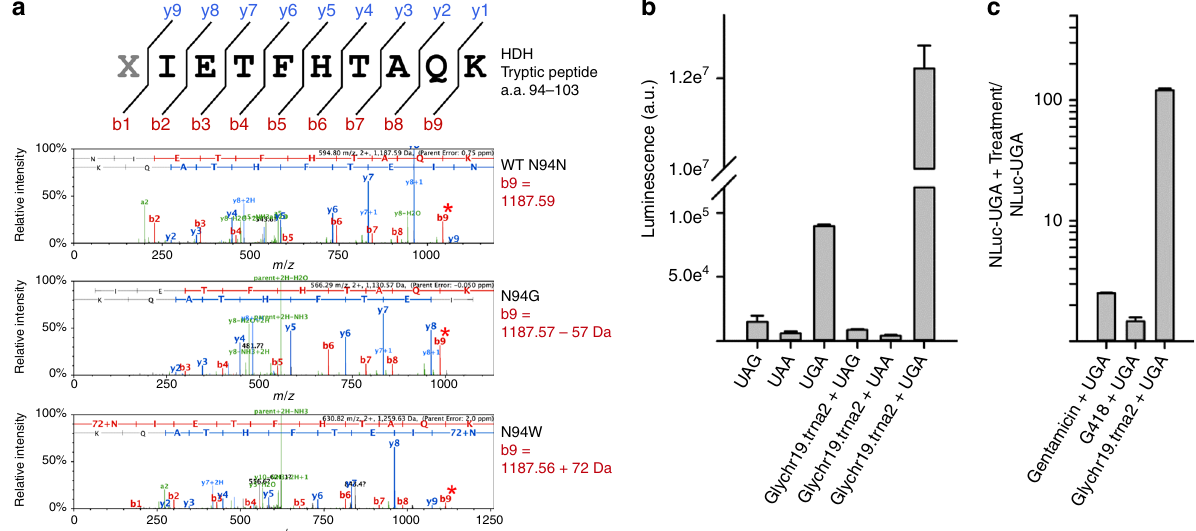
Fig. 3 Cognate encoding and high- fi delity suppression by engineered tRNA . a Tryptic fragment of histidinol dehydrogenase (HDH), where X indicates suppressed PTC codon. MS/MS spectra of the tryptic fragment with masses of indicated y and b ions for WT (top), N94G (middle), and N94W (bottom) HDH. b9 ion mass is shifted by the predicted mass of − 57 Da and + 72 Da from the WT asparagine, indicating the encoding of cognate amino acids glycine and tryptophan by ACE-tRNA Gly and ACE-tRNA Trp (Trp-chr17.trna39), respectively. b ACE-TGA - tRNA Gly (Glychr19.trna2) selectively suppresses the UGA stop codon in transiently transfected HEK293 cells. c ACE-tRNA Gly transfection outperforms both gentamicin (40 µ M; n = 3) and G418 (140 µ M; n = 3) following a 48 h incubation in Hek293 cells stably expressing NLuc-UGA. Data is presented as standard error of mean in b and